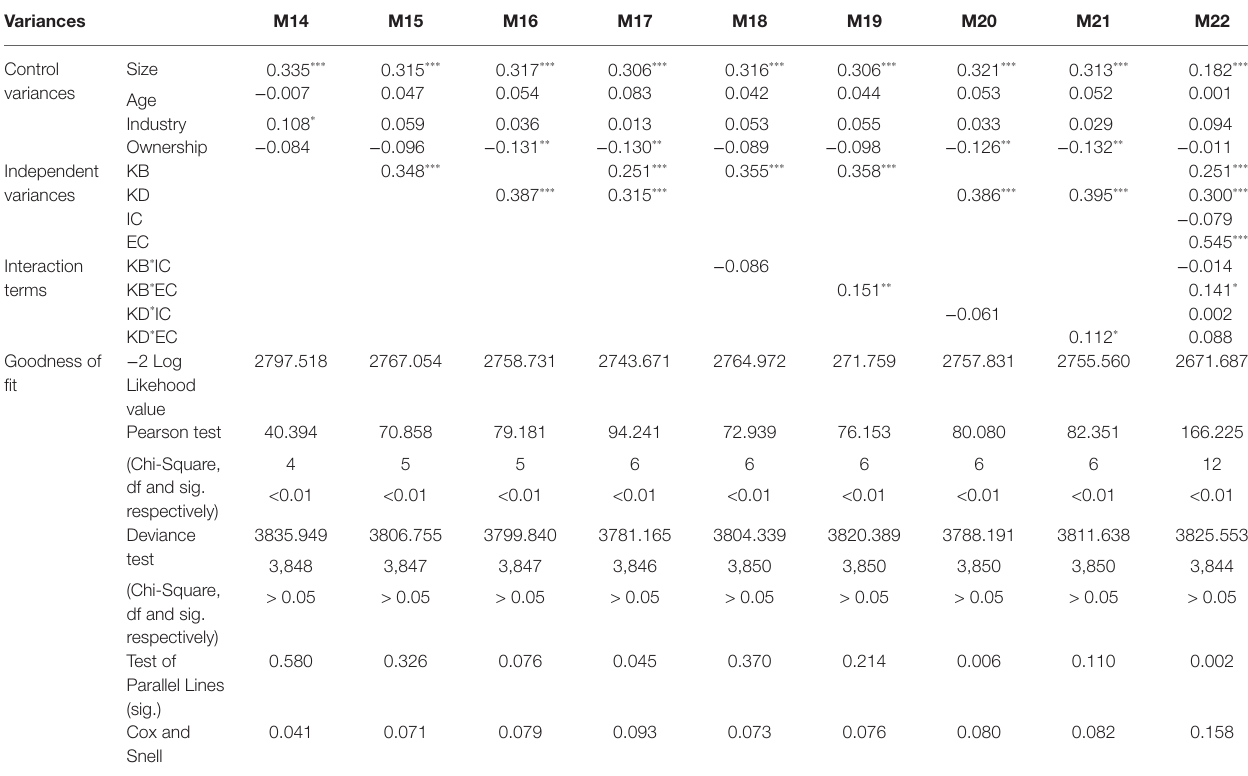
TABLE 5 | Results of ordered multiple-classification logistic regression analysis of business model innovation.